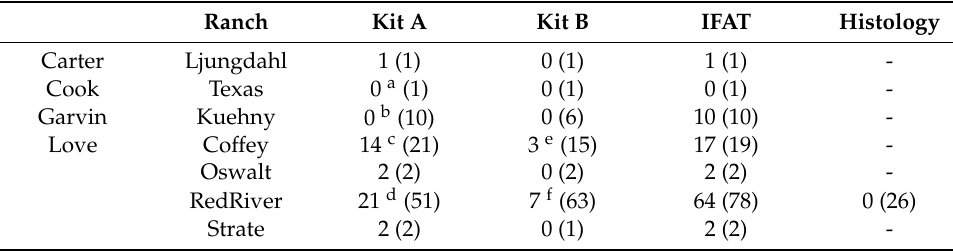
Table 2. Serological and histological results from 116 wild pigs captured from southcentral. Okla- homa, 2015 through 2018. Positive samples reported with total samples tested in